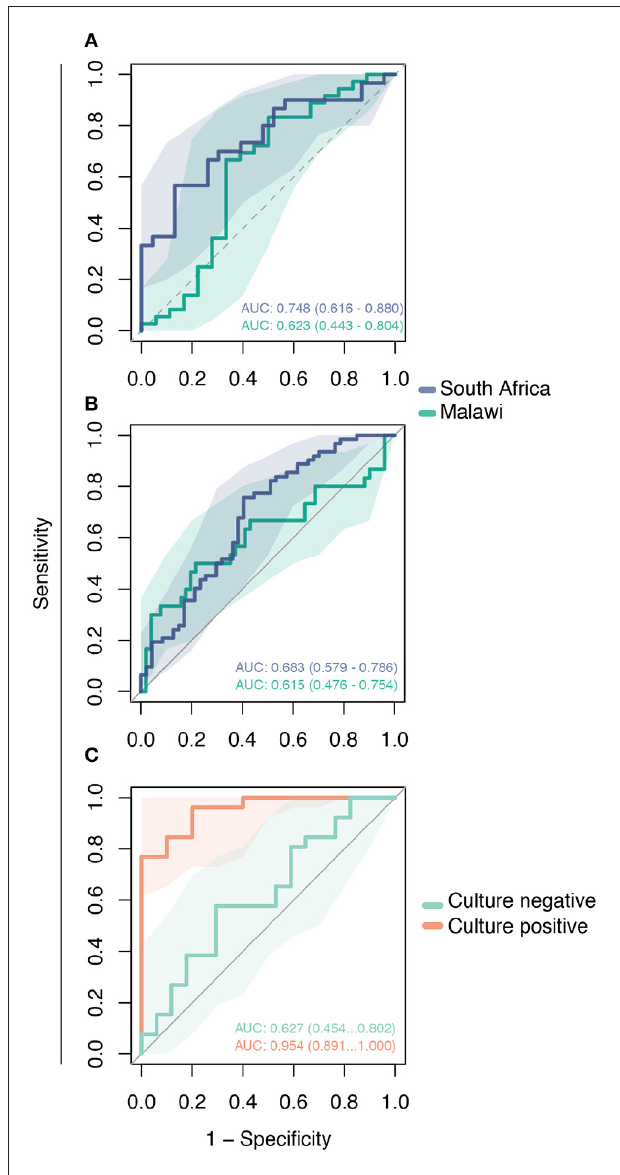
FIGURE 4 | Validation of the Decision-tree gene signature using publicly available microarray datasets. Receiving operating characteristic curve analysis evaluating the performance of the 2-gene signature to distinguish comparison groups in the: (A) GSE39940 dataset—children living with HIV from South Africa and Malawi coinfected with TB or other respiratory diseases (ORD) (HIV-TB vs. HIV-ORD); (B) GSE37250 dataset—adults living with HIV from South Africa and Malawi coinfected with TB or ORD (HIV-TB vs. HIV-ORD); and (C) GSE39939 dataset from Kenya—patients with HIV-TB co-infection with and without culture-confirmed TB (culture-positive vs. culture-negative).